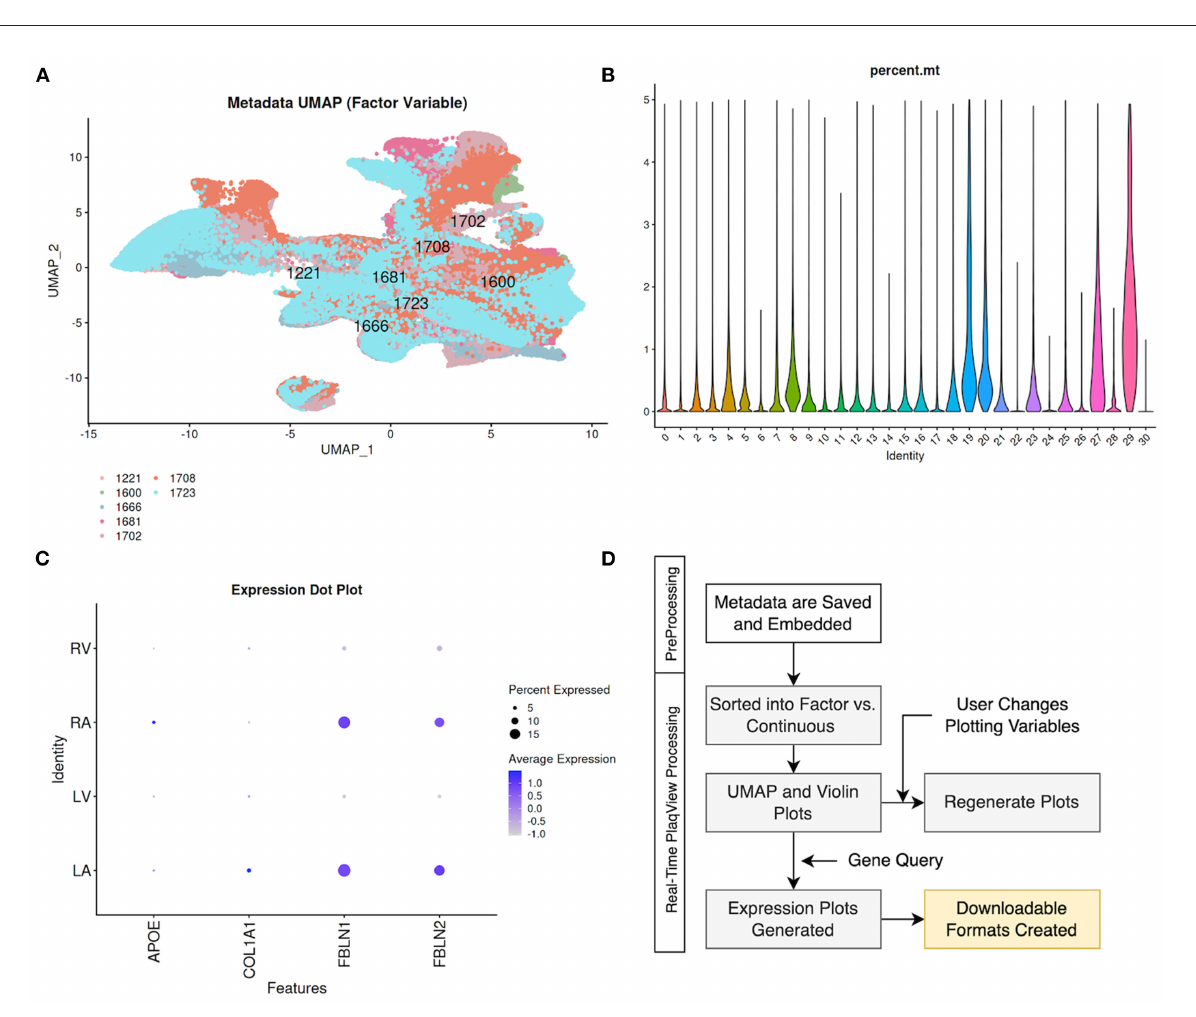
FIGURE6 Metadata Explorer enables visualization and query of unabridged cell-level metadata. When available, cell-level metadata are divided into (A) factor-type such as cells separated by “biological_individuals,” and (B) continuous-type such as percent mitochondria by seurat cluster for visualization. (C) Users can also query gene expression based on factor-type metadata such as the heart “chamber” in the case of Tucker et al. (31). (D) We embed the metadata during the preprocessing stage and PlaqView sorts the metadata and runs calculations in response to the user selection to generate corresponding UMAPs and Violin